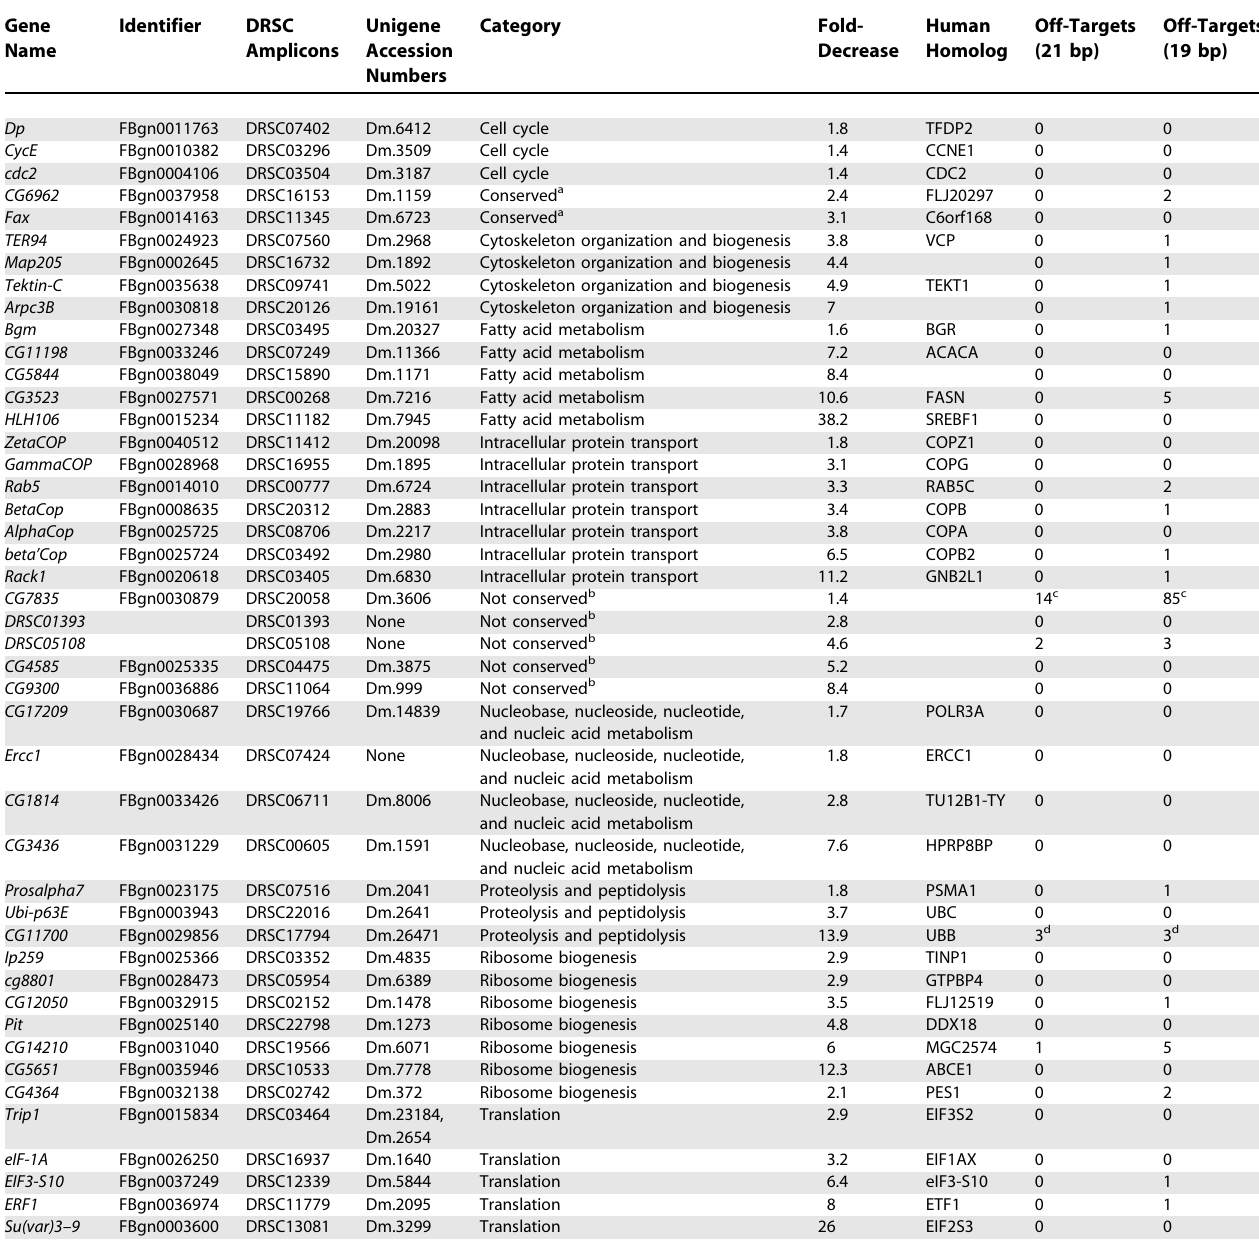
Table 1. Nonribosomal Genes Required for DCV